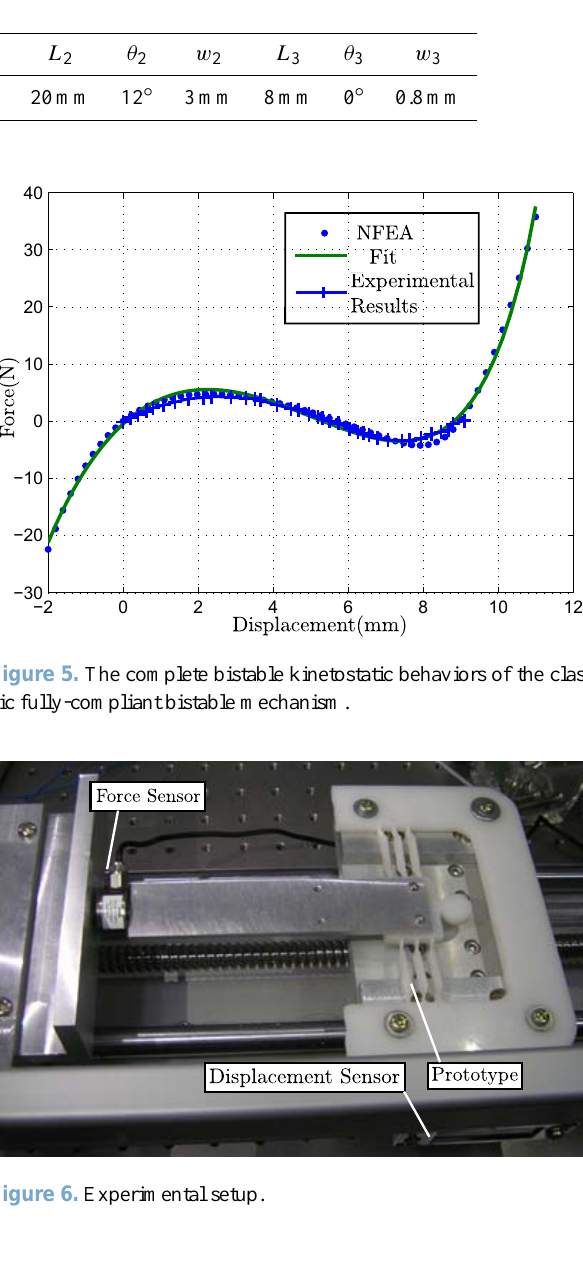
Table 1. Design parameters of a classic fully-compliant bistable mechanism. H is the out-of-plane thickness of the mechanism, E is the Young’s modulus of polypropylene.